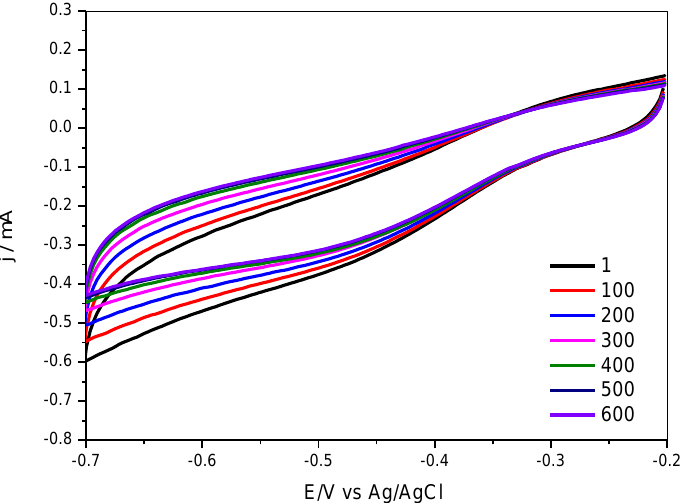
Figure 12. Stability test: cyclovoltammograms for PSU-TMA + PANI + GAH-Oct in O 2 saturated 1 M